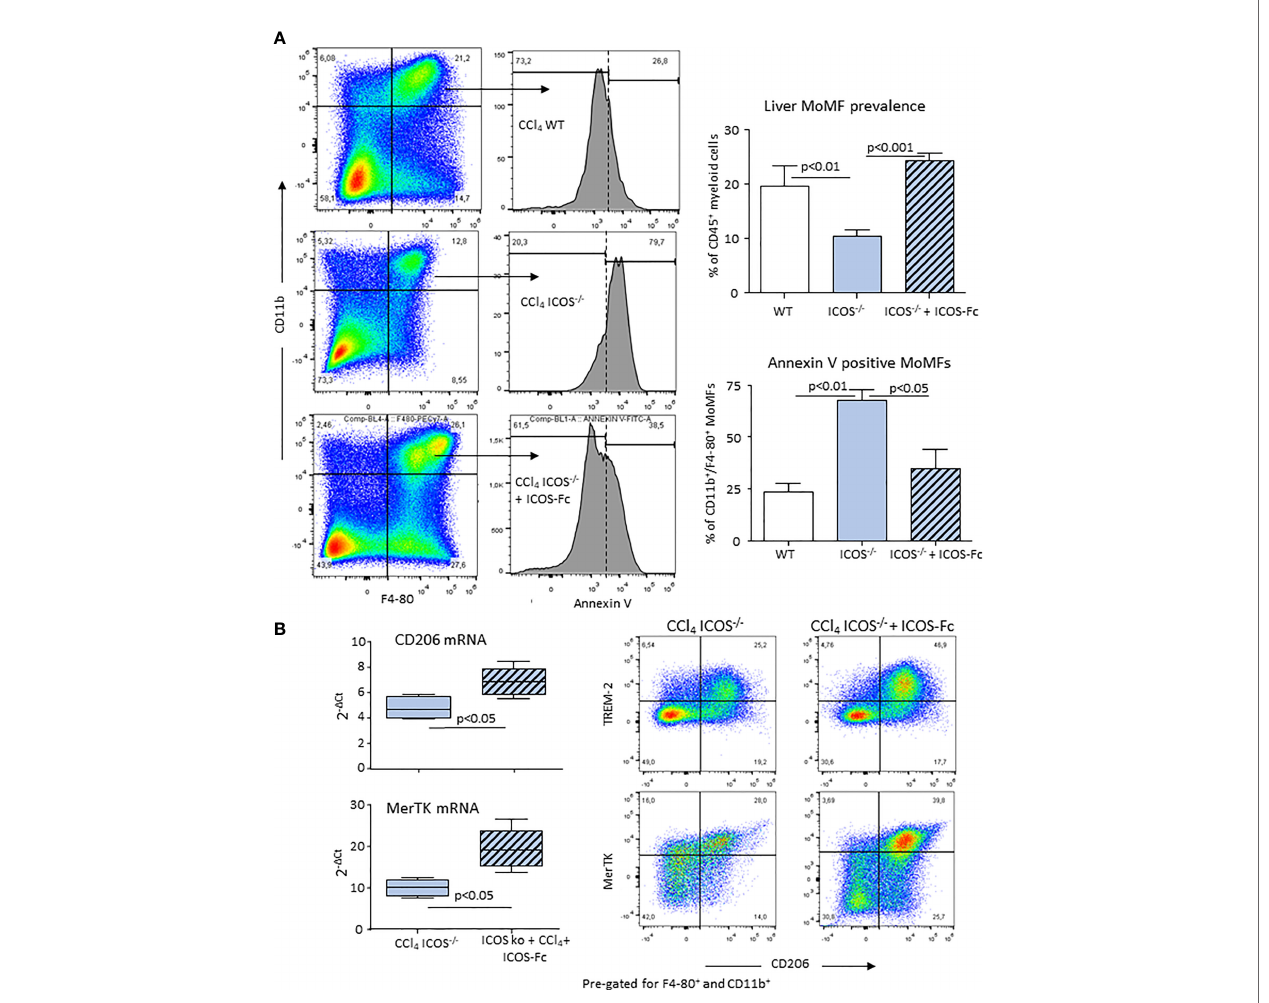
FIGURE 7 | ICOS modulates the survival of reparative MOMFs during the resolution of acute liver injury. Annexin V staining of apoptotic CD11b + /F4-80 + MoMFs and the overall MoMF prevalence were evaluated by fl ow cytometry in the liver of wild-type and ICOS -/- mice 72 hours after receiving CCl 4 in combination or not with recombinant ICOS-Fc treatment (A) . Real-Time PCR analysis of the hepatic transcripts for CD206 and MerTK and Hepatic distribution of CD206 + /TREM-2 + /MerTK + reparative MoMFs in ICOS -/- mice receiving CCl 4 for 72 hours with or without ICOS-Fc supplementation (B) . The results are expressed as mean ± SD of 3-4 different cell preparations of 5-6